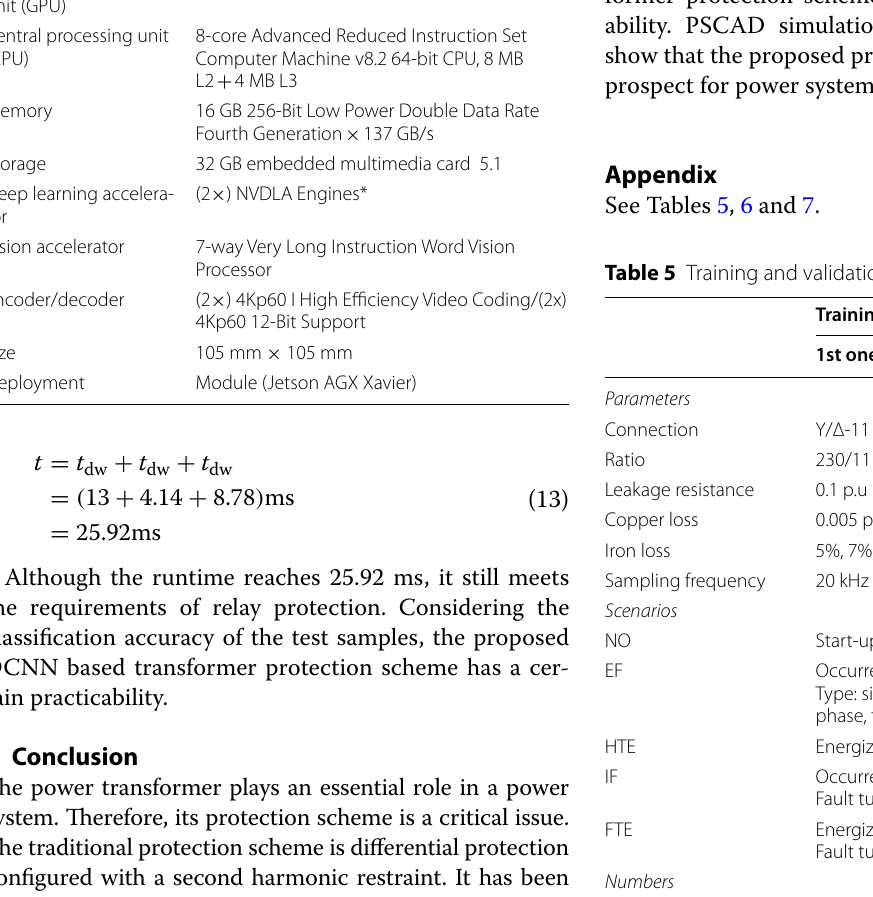
Table 4 Parameters of developer kit Graphics processing 512-core Volta GPU with Tensor Cores unit (GPU)